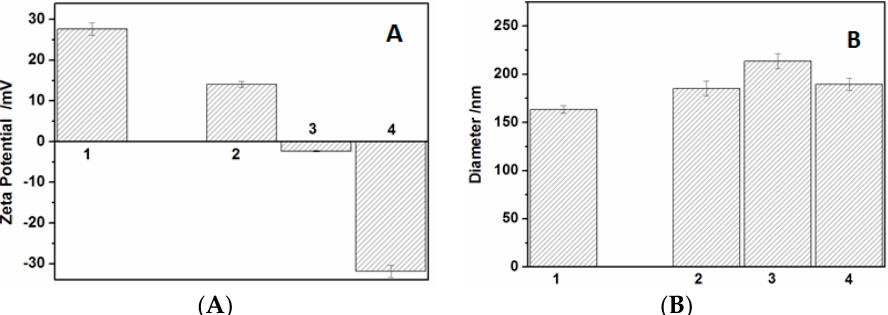
Figure 2. Surface charge ( A ) and particle size; ( B ) characterization of DNA/PEI/PPSD ternary complexes at pH 7.4. Lane 1 to 4, DNA/PEI/PPSD at ratios ( wt/wt/wt ) of 1:1:0, 1:1:8, 1:1:16, and 1:1:32, respectively.